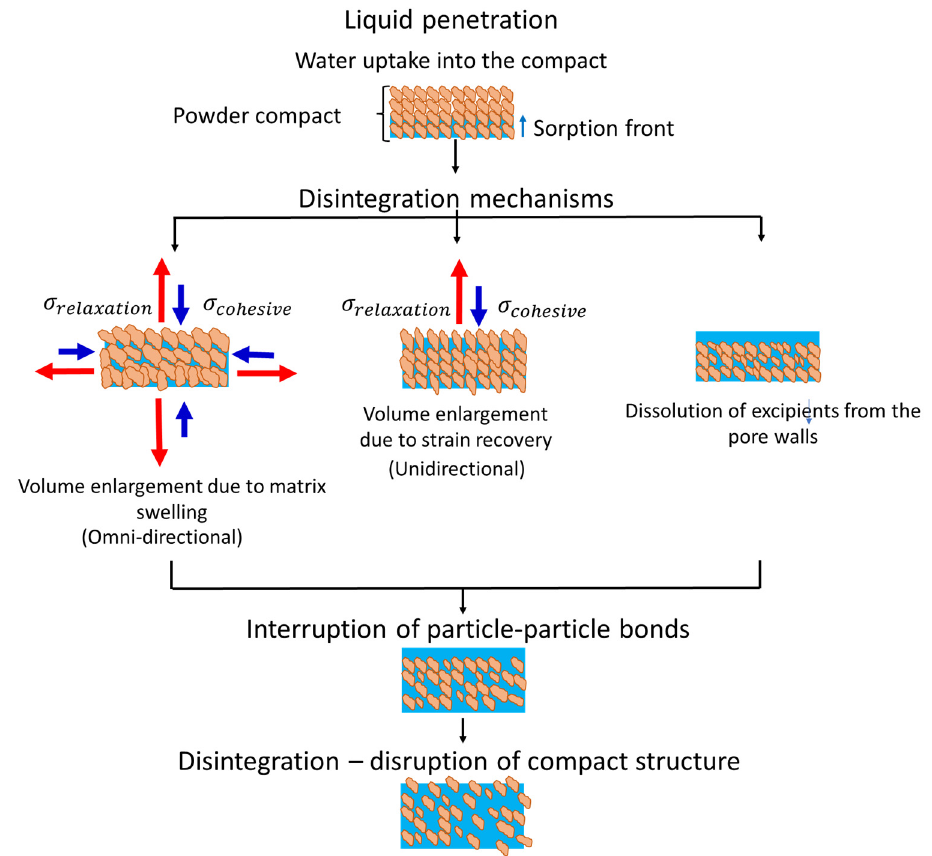
Figure 2. Schematics of the disintegration mechanisms. The blue arrowhead ( σ cohesive ) represents the conservative stresses withholding the tablet structure, while the red arrowhead ( σ relaxation ) represents the dissipative/relaxation stresses trigged by disintegration onset. Adapted from: Markl and Zeitler [3]—Open access.